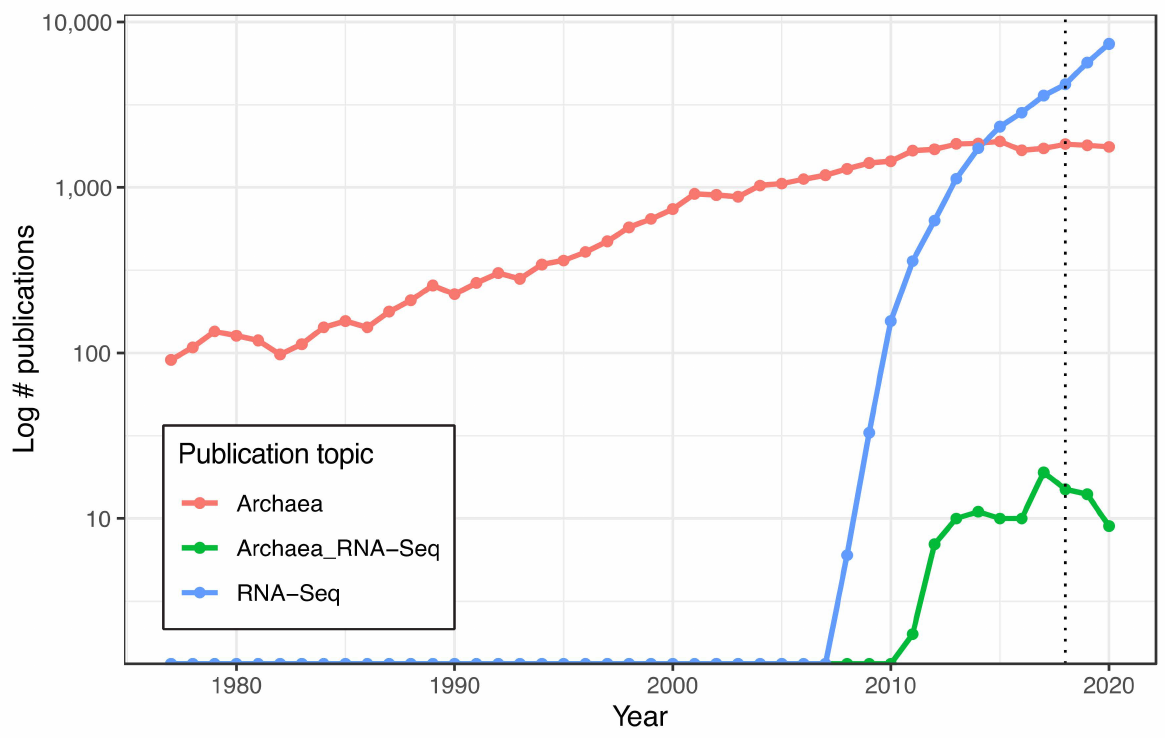
Figure 1. Slowdown in Archaeal RNA-Seq publications in recent years . Lines depicting number of publications per year detected in the NCBI PubMed databased searched with the terms “Archaea” (red), “RNA-Seq” (blue), and “Archaea RNA-Seq” (green), plotted on log-scale y-axis. Dotted line at 2018 marks discontinuation of the Illumina RiboZero